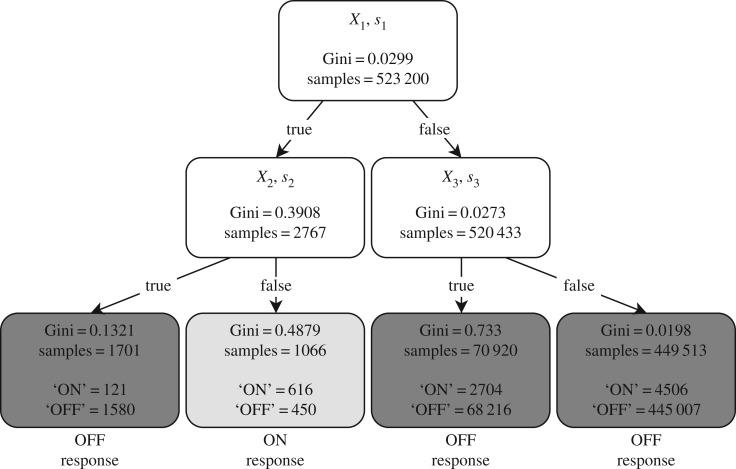
Simple qualitative decision tree with a maximum depth of two. The responses arewhether or not the probe is on or off the AF driver. Three features (X1,X2 and X3) with their corresponding thresholds (s1,s2 and s3) are used to create the response regions.